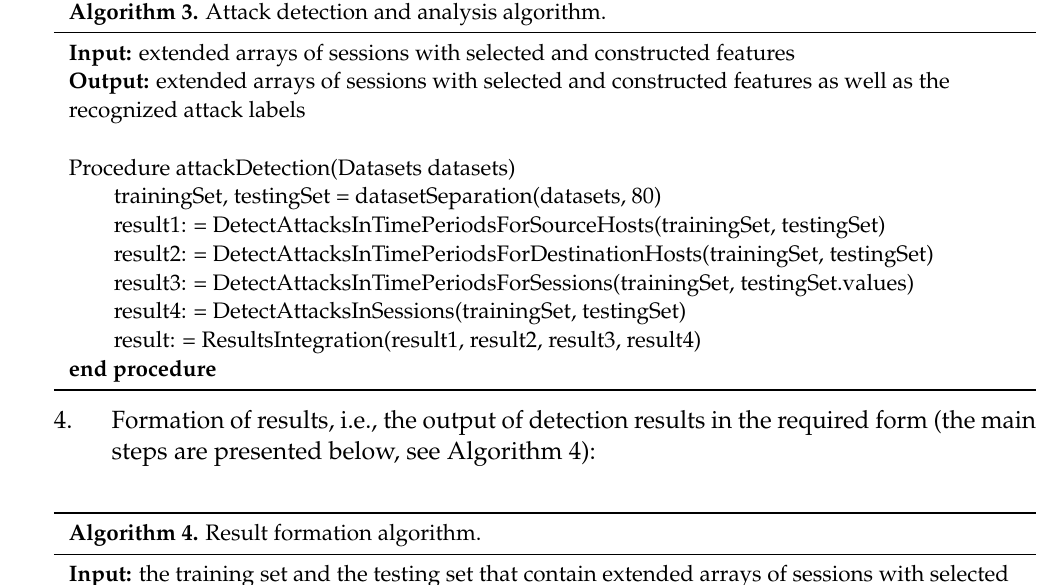
Algorithm 3. Attack detection and analysis algorithm.